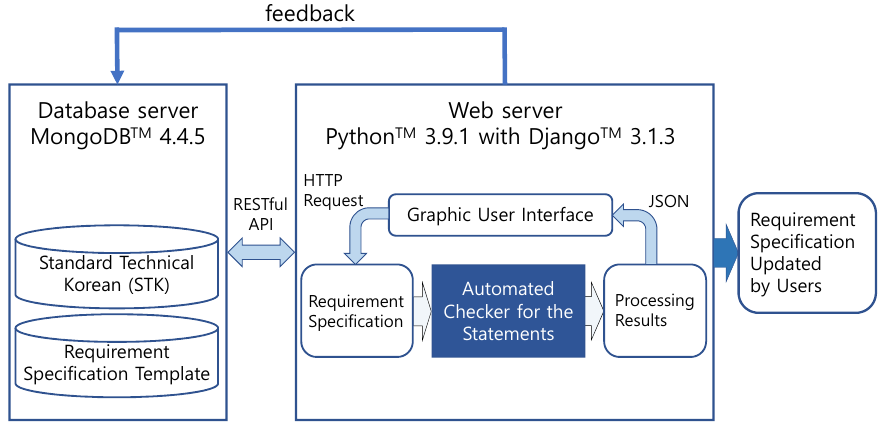
Figure 2. The architecture of the automated checker for the correctness of requirement